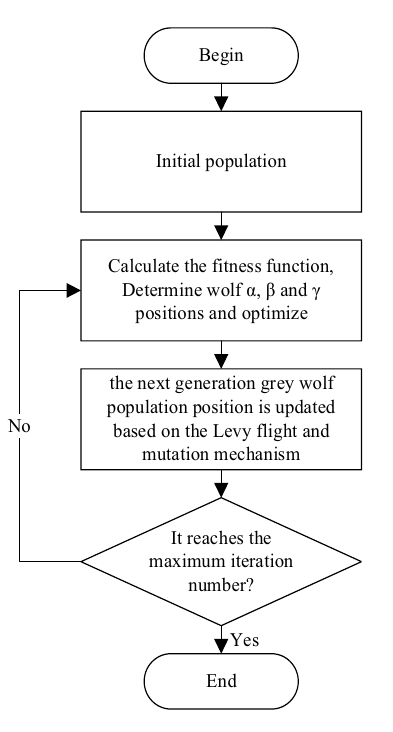
Figure 4. The flow chart of the improved grey wolf